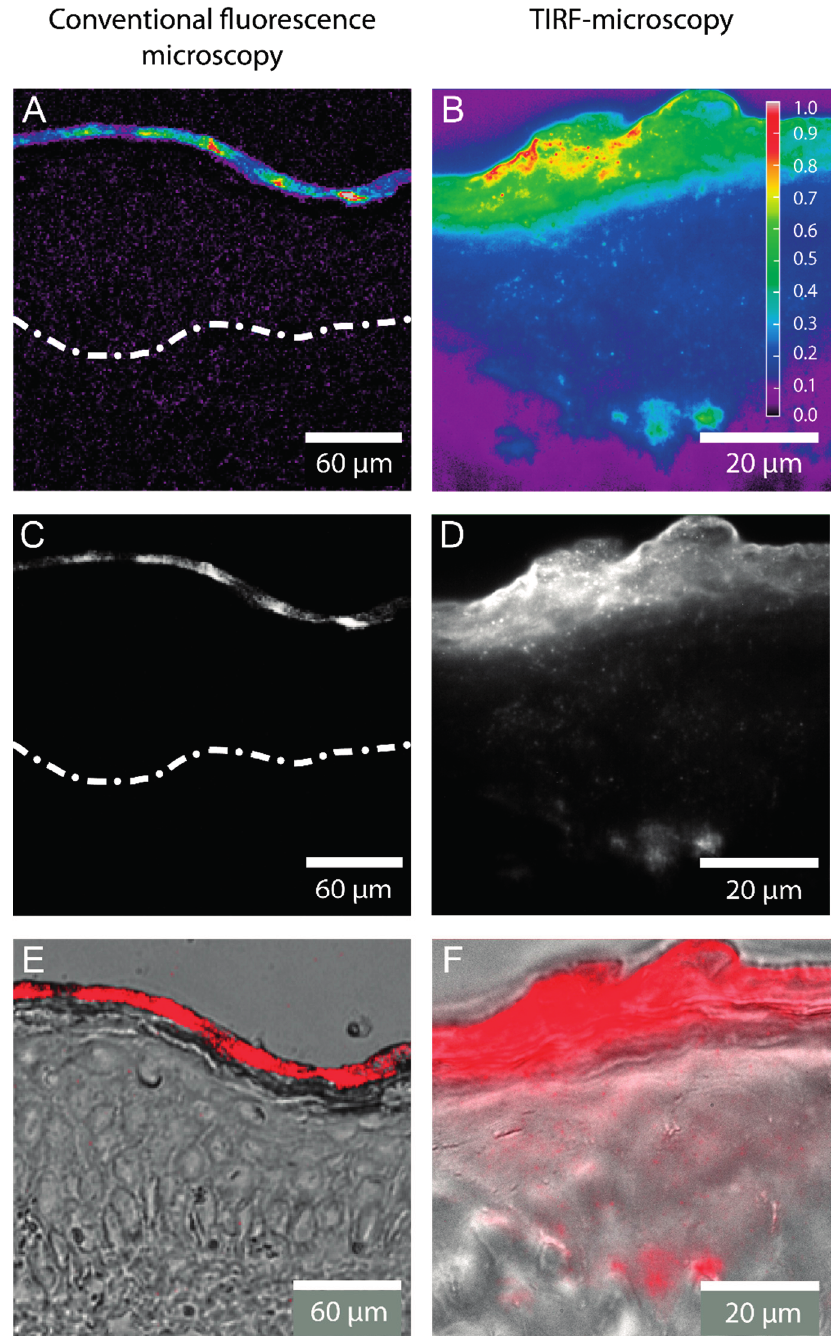
Figure 2. Fluorescence microscopy images of a cryosection through excised human skin with ATTO-Oxa12 applied topically as obtained by conventional fluorescence microscopy and total internal reflection fluorescence (TIRF) microscopy. False color coded images representing the relative fluorescence intensity are shown in ( A , B ); while ( C , D ) display grayscale intensity images. The white spots in ( D ) indicate ATTO-Oxa12 molecules in the stratum corneum (SC) and the viable epidermis; ( E , F ) are digital overlays of fluorescence microscopy images (here red) from ( C , D ) with bright-field microscopy images of the skin. The broken line in ( A , C ) indicates the barrier between the viable epidermis and the